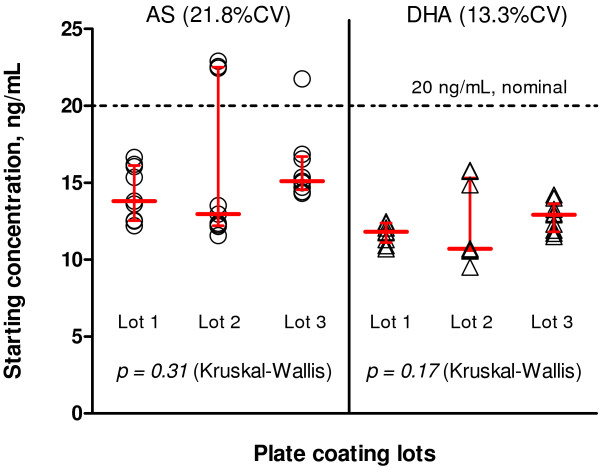
Starting AS and DHA concentrations used for serial dilutions on in vitro drug culture plate lots for the HRP-2 assay. The dashed line indicates the nominal final starting concentration of 20 ng/mL after addition of sample for both drugs. Red lines indicate medians and interquartile ranges for drug concentration. From three drug-coated plate lots, a total of 27 starting wells collected were measured (three wells/plate x three plates/lot).